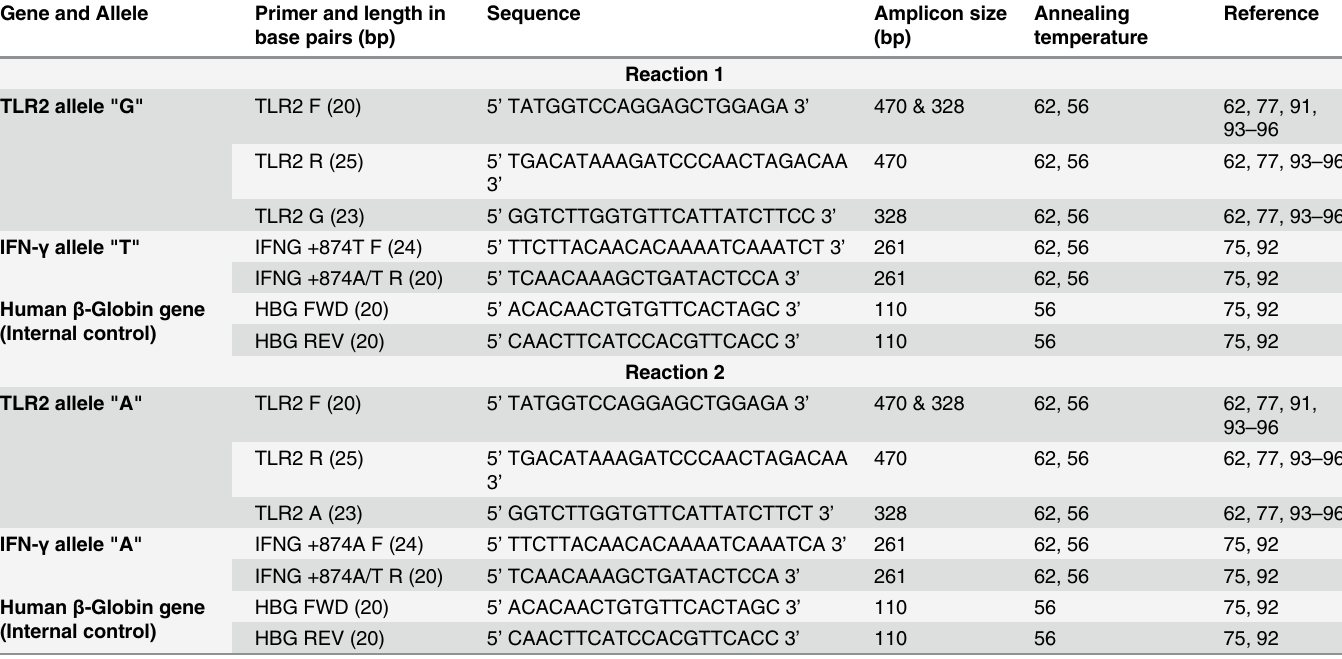
Table 1. Primers used for the detection of polymorphism among TLR2 2258G/A (Arg753Gln) and IFN- γ (+874T/A) genes. Gene and Allele Primer and length in Sequence Amplicon size Annealing Reference base pairs (bp) (bp) temperature Reaction 1 TLR2 allele "G"